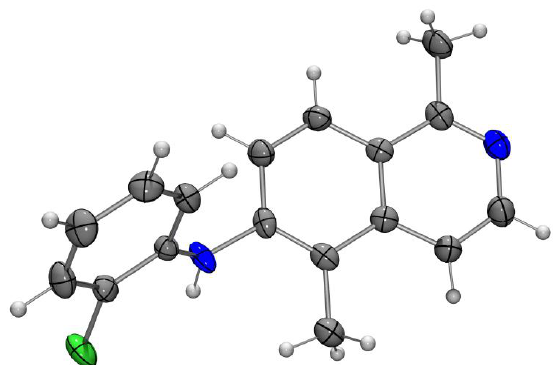
Figure 2. Molecular structure of the diarylamine 18a in the crystal (ORTEP plot showing thermal ellipsoids at the 50% probability level).